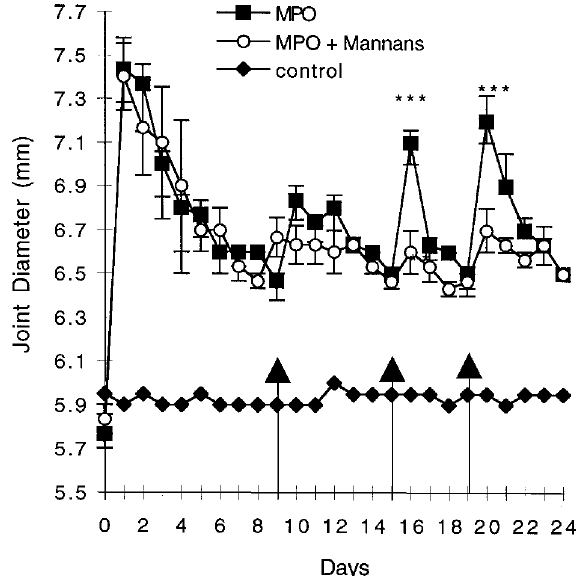
FIG. 3. The inhibition of peri-articular swelling after simulta- neously injecting enzymatically active myeloperoxidase (MPO) and anti-tumor necrosis factor-alpha (anti-TNF a ). On day 0, animals were injected with 10 m l PG-APS (2 m g of rhamnose/joint) in the left ankle joint and 10 m l normal saline in the right ankle joint. After the treated ankle joint returned to ‘baseline’ levels of swelling and erythema, the re-injecting regimen was started. On days 9, 15, and 19 (as depicted by the arrows), animals were re-injected simultaneously in the left ankle joint with one of the following: 10 m l MPO alone (2 m g/joint), or a combination of 5 m l MPO (2 m g/joint) and 5 m l anti-TNF a . The right ankle joint was re-injected with 10 m l normal saline. These values represent the results of 3–5 animals. The experiment was repeated at least once. The concentrations reflected in the graph are those injected into the joint. *** P £ 0.001.